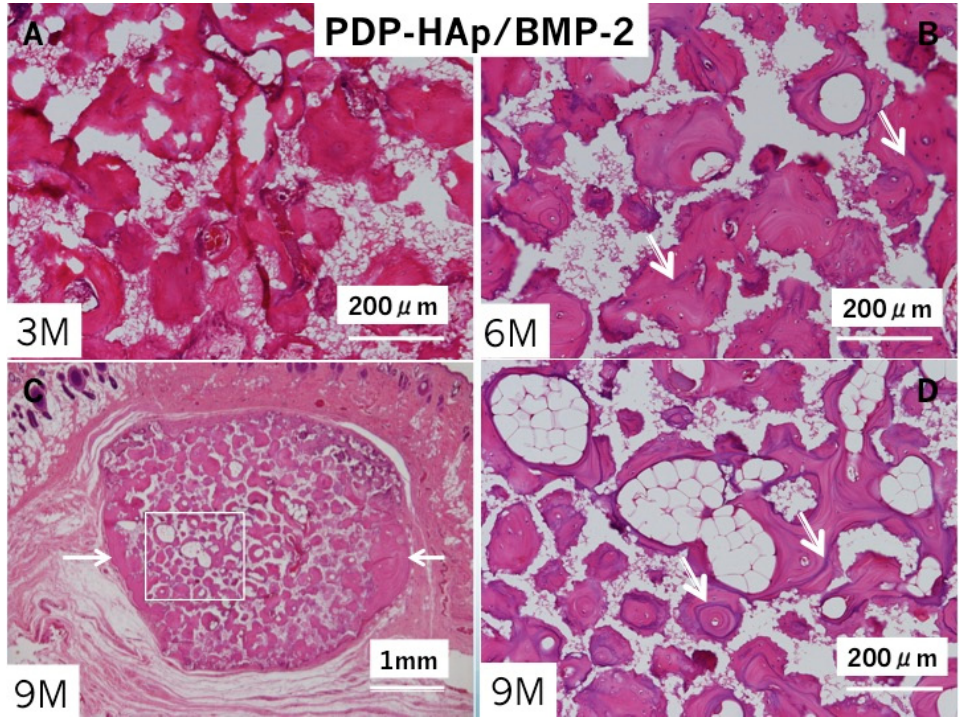
Figure 5. Histological photographs of HE sections in PDP-HAp/BMP-2. ( A ) Bone induction in macro/micro-pores at three months. Note: no cartilage. ( B ) Bone induction in all pores at six months. Arrows: remodeling lines. ( C ) Whole appearance at nine months. Bone induction in pores and surroundings of PDP-HAp. Arrow indicating dense bone area. ( D ) Higher magnification of rectangle in ( C ). Induced bone with fatty marrow in interconnected pores at nine months. Arrows: remodeling lines.